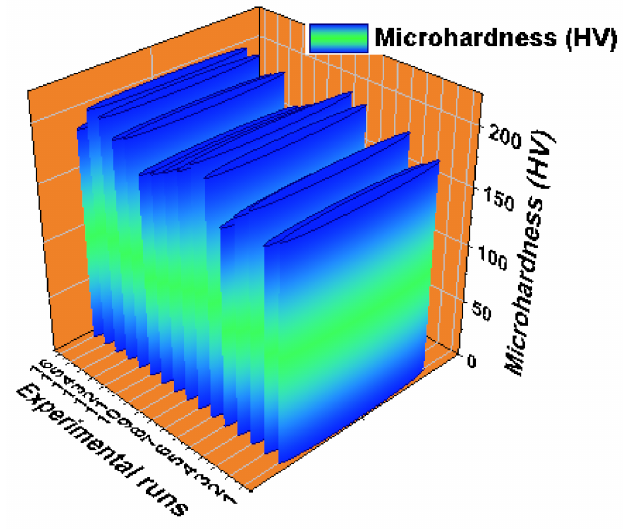
Figure 21. 3D bar plot: experimental runs vs. micro